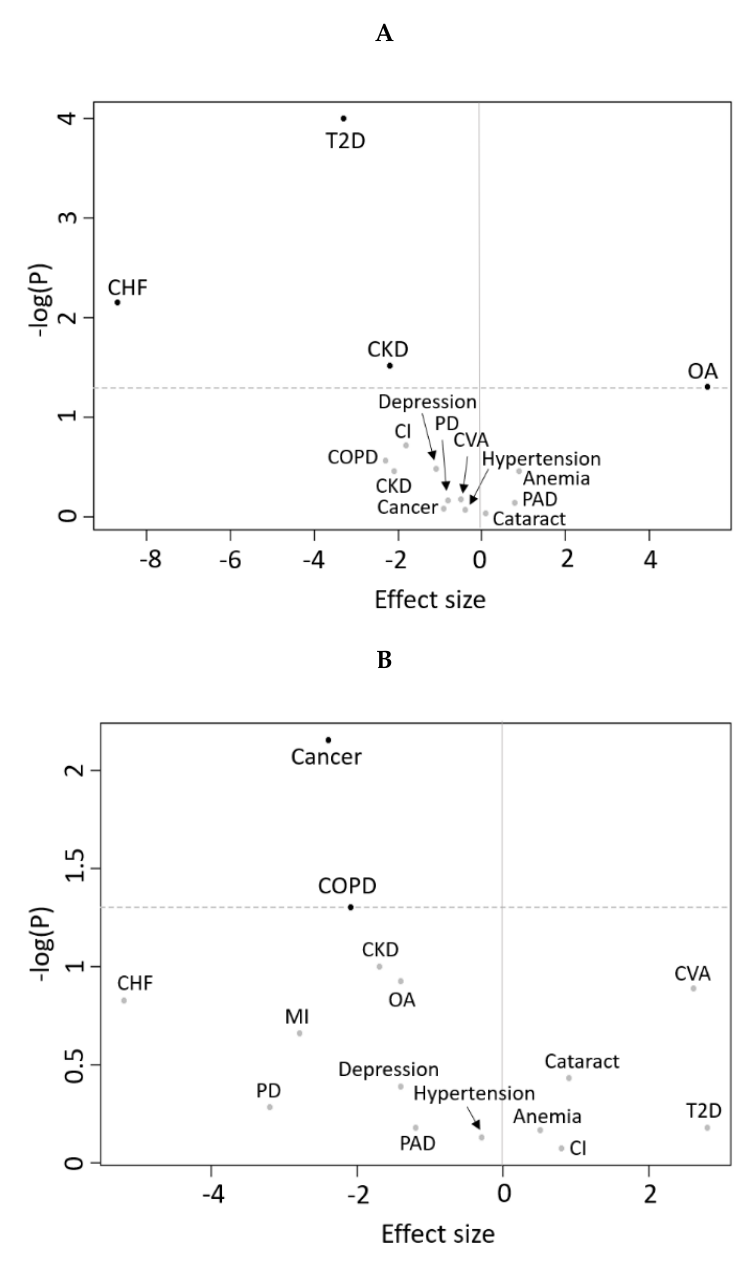
Figure 3. Volcano plots of the association between diseases and RMR rate of change over time. In panel ( A ), subjects free of disease at baseline that developed the disease during the follow-up are considered in comparison to subjects that never developed the disease, adjusting for age, sex, lean and fat body mass, and changes in lean and fat body mass. In panel ( B ), subjects a ff ected by the disease at baseline are considered in comparison to subjects that never developed that disease, adjusting for age, sex, lean and fat body mass, and changes in lean and fat body mass. The dotted line represents p value = 0.05. E ff ect size refers to the beta coe ffi cient of the association between disease and RMR rate of change. CHF, chronic heart failure; MI, myocardial infarction; CVA, cerebrovascular accidents; T2D, type 2 diabetes mellitus; PAD, peripheral artery disease; CI, cognitive impairment; PD, Parkinson’s disease; CKD, chronic kidney disease; COPD, chronic obstructive pulmonary disease; OA, osteoarthritis. Prevalent COPD and cancer were associated with a steeper decline in RMR, independent of age, sex, and body composition (Figures 2 and 3B). No other incident or prevalent disease status was associated with significant di ff erential change in RMR over